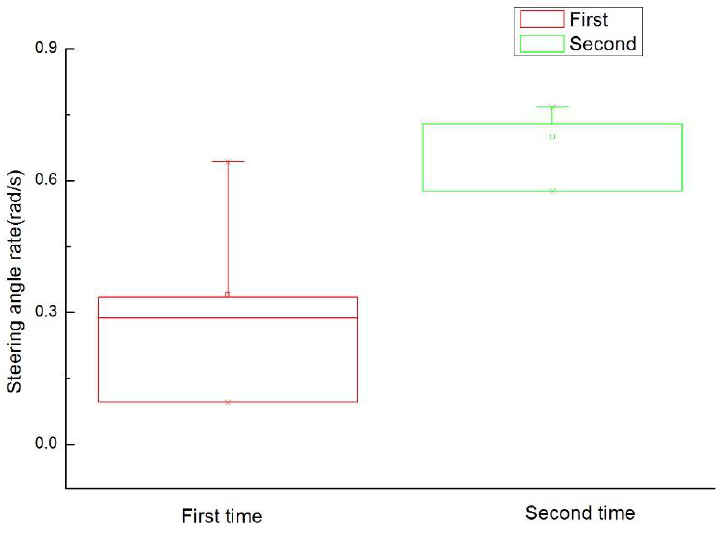
Figure 5. The relationship between the maximum steering wheel angle rate and the TTC when starting to control the car.